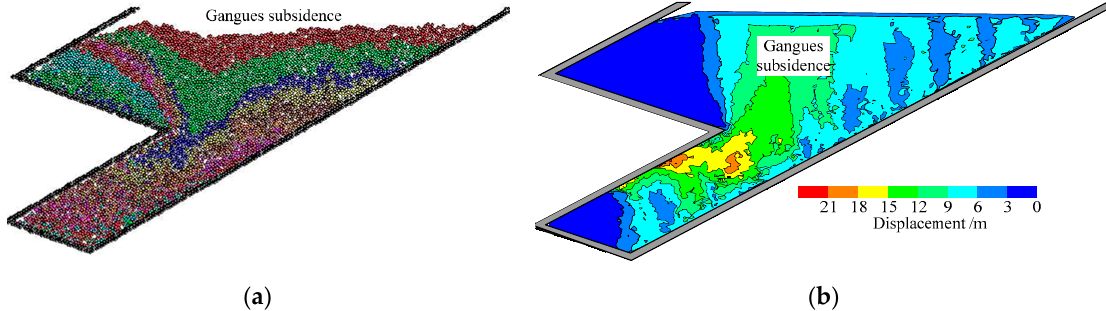
Figure 9. Gangue backfilling characteristics at the large-scale subsidence stage: ( a ) backfilling form and ( b ) displacement distribution.